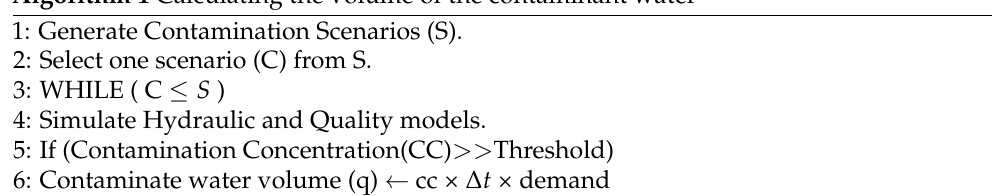
Algorithm 1 Calculating the volume of the contaminant water